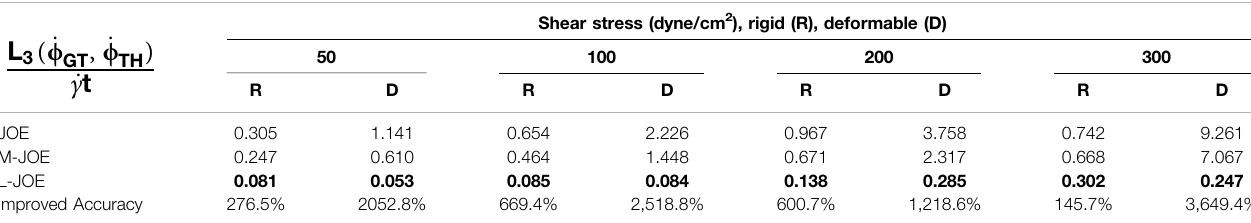
TABLE 1 | Overall normalized accuracy comparisons by different physics